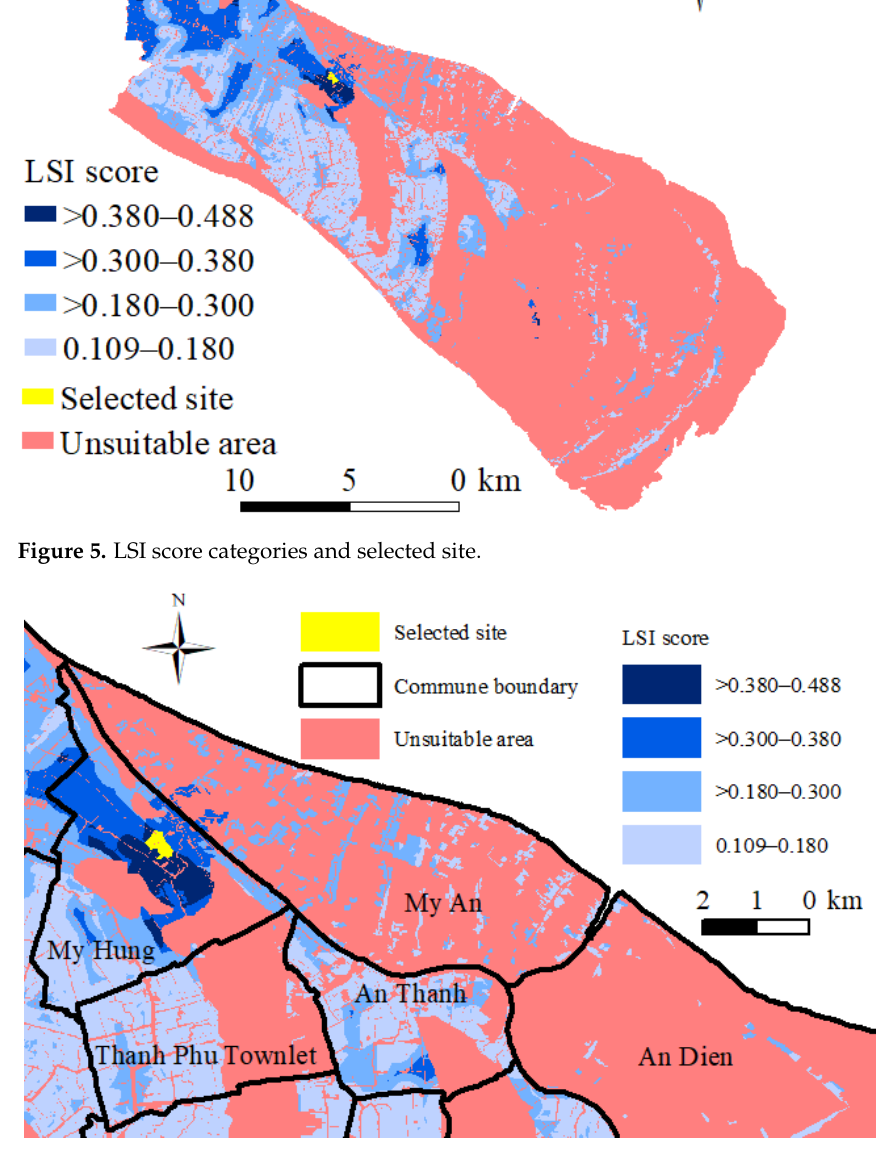
Figure 6. Selected site located in My Hung commune.